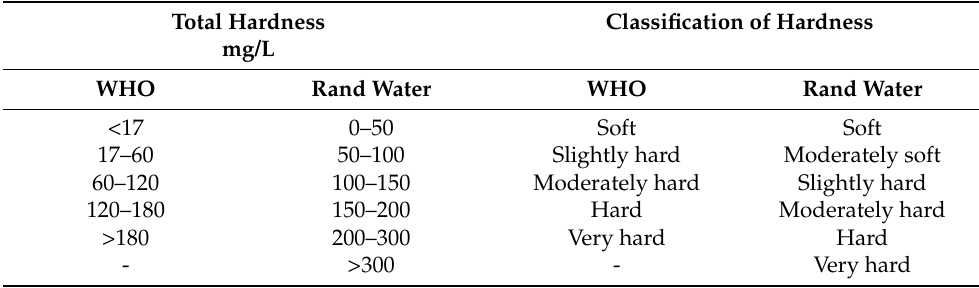
Table 2. Classification of water hardness according to WHO and rand waters. Total Hardness Classification of